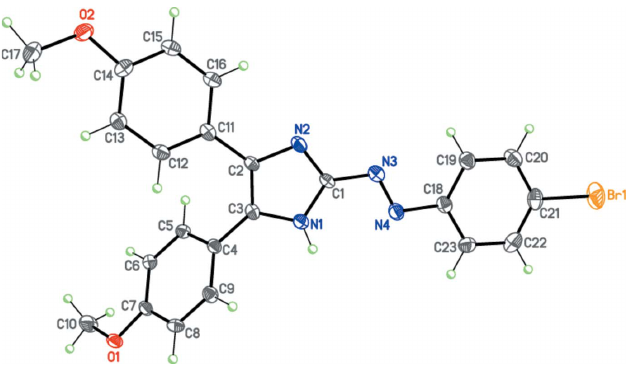
Figure 1 Molecular structure of the title compound. Displacement ellipsoids are shown at the 50% probability level. The hydrogen atoms are presented as small spheres of arbitrary radius.